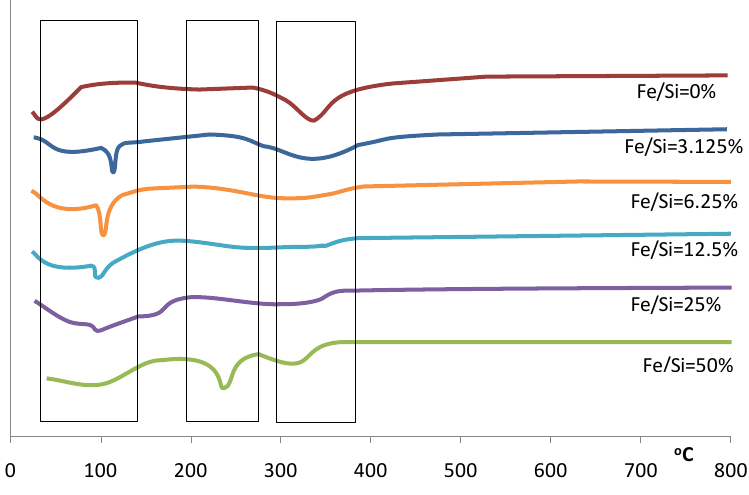
Fe/Si=6.25%Fe/Si=3.125%